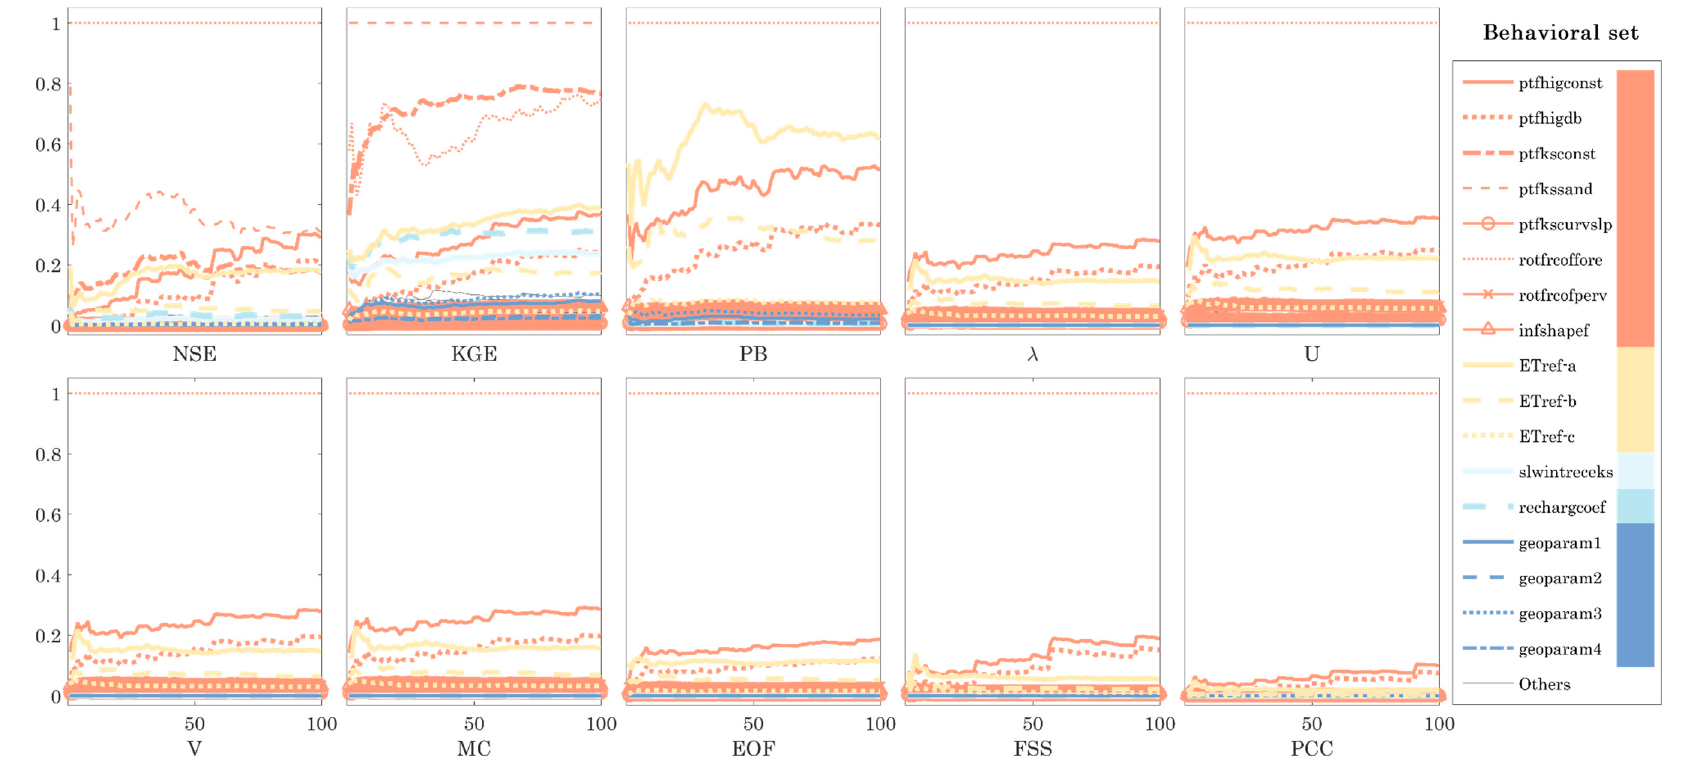
Figure 3. Average accumulated relative parameter sensitivities over 100 behavioral (NSE > 0.5) initial parameter sets and one-at-a-time parameter perturbations. The different colors indicate different model processes. The red coded parameters refer to soil moisture, yellow to evapotranspiration, ice blue to interflow, light blue to percolation, and dark blue to geology.